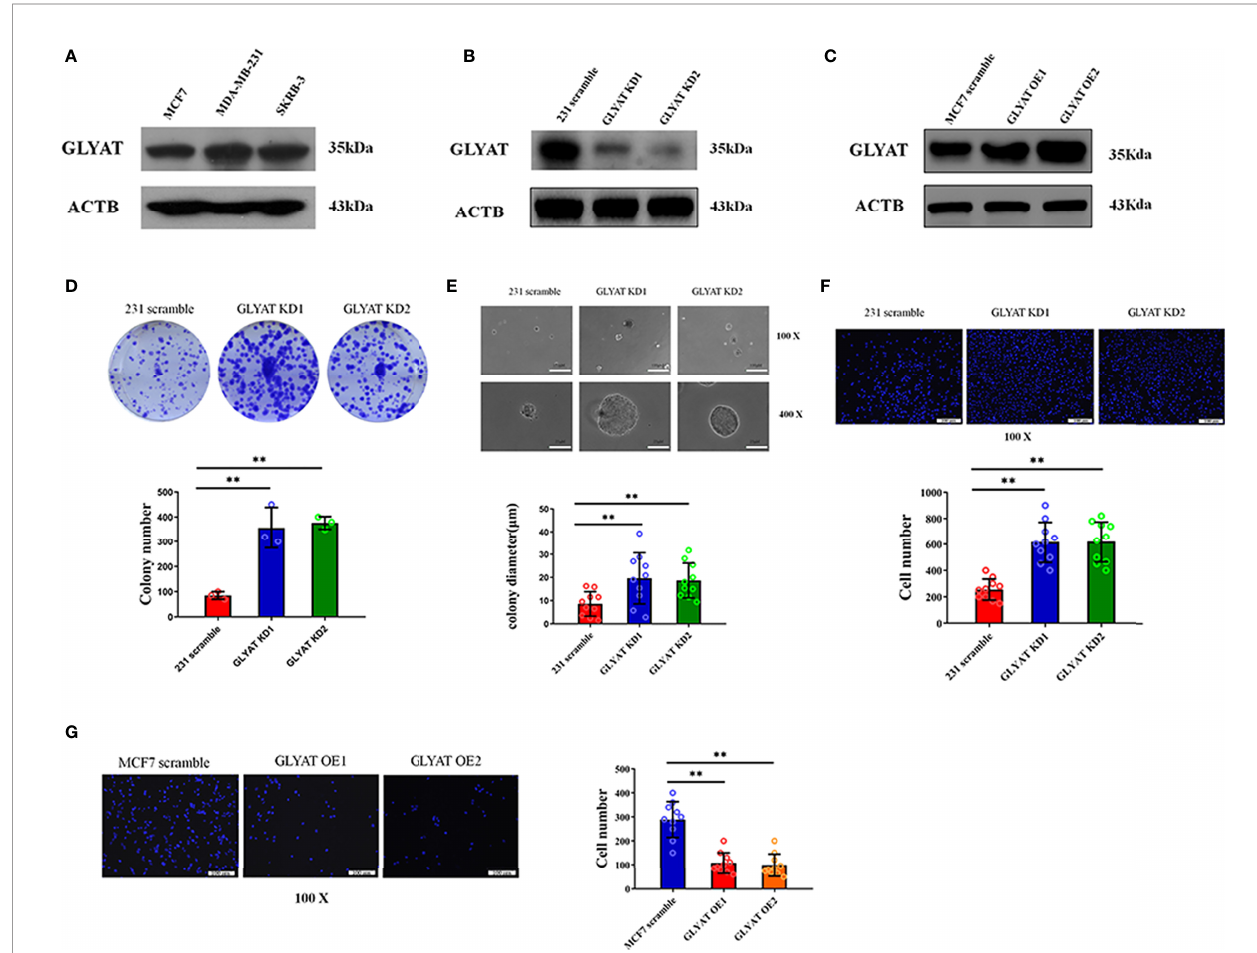
FIGURE 2 | GLYAT suppresses BC cell proliferation and metastasis. (A) GLYAT protein level was assessed in different BC cell lines. (B) MDA-MB-231 cells were transfected with GLYAT KD plasmid and a scrambled plasmid as control. The suppression of GLYAT in MDA-MB-231 cells was con fi rmed at the protein level. (C) MCF-7 cells were transfected with GLYAT OE plasmid and a scrambled plasmid as control. The over expression of GLYAT in MCF-7 cells was con fi rmed at the protein level. (D, E) GLYAT KD in MDA-MB-231 cells signi fi cantly increased colony numbers and size compared with the scramble cells. (F) Transwell assay revealed that the migration ability of MDA-MB-231 cells was signi fi cantly increased following transfection with GLYAT KD1 and KD2 compared with the scramble control. (G) Transwell assay revealed that the migratory ability was signi fi cantly decreased in MCF-7 cells GLYAT OE compared with scramble control. ** p < 0.01. Scale bars for (E) are 100 m m and 25 m m, and for (F, G) are 100 m